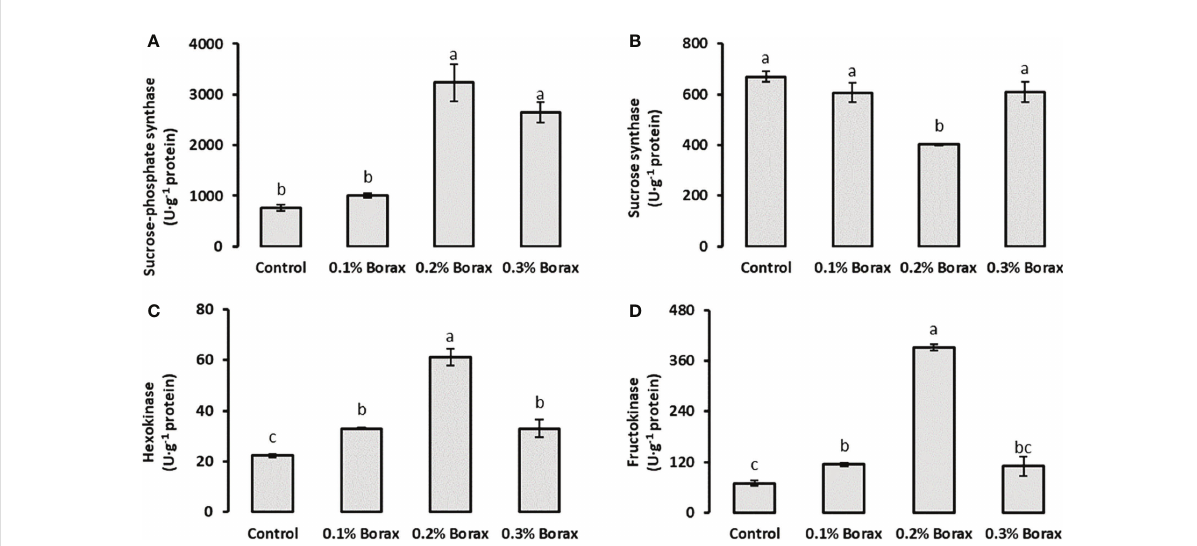
FIGURE 5 Effect of foliar application of B on the activities of key enzymes involved in soluble sugars metabolism i.e., sucrose-phosphate synthase (A) , sucrose synthase (B) , hexokinase (C) and fructokinase (D) of loquat fruits. Same letters indicate non-signi fi cant difference among treatments according to Fisher ’ s least signi fi cant difference (LSD) test, when p ≤ 0.05 . Vertical bars indicate mean ± standard error (n=4, 4-block RCBD arrangement).